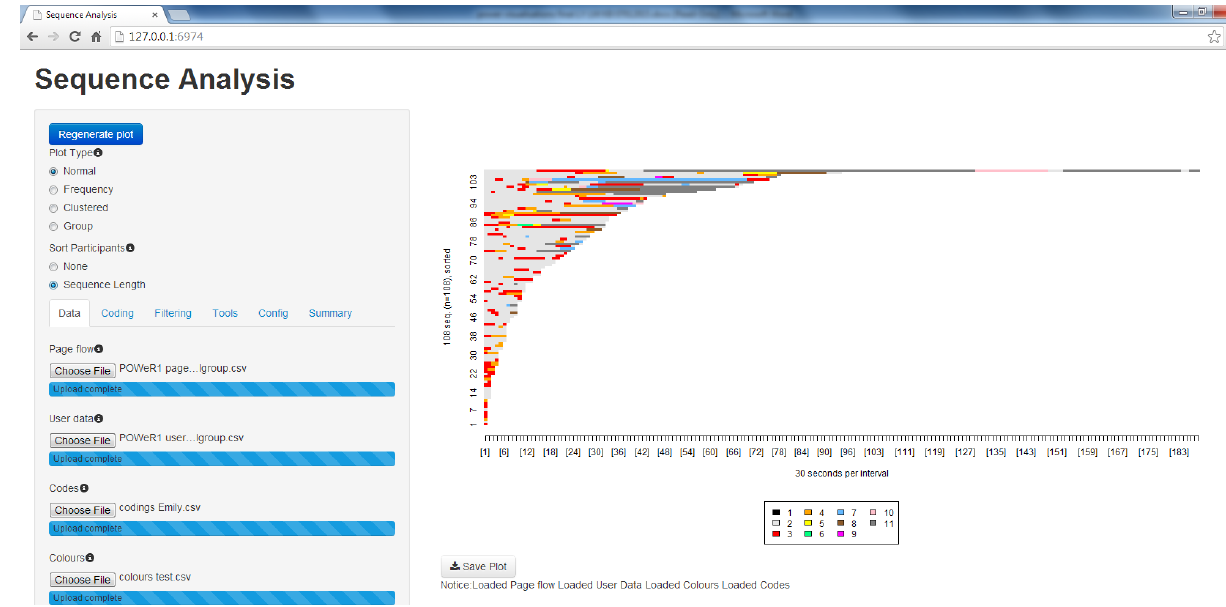
Figure 1. Screenshot of the visualization tool.